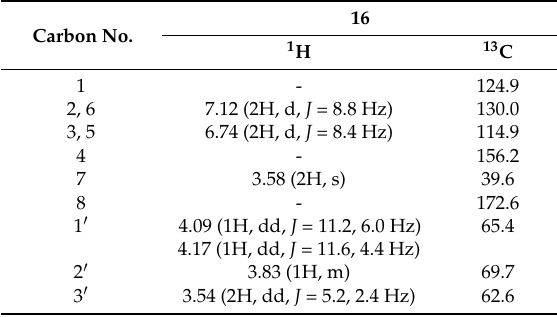
Table 2. 1 H- and 13 C-NMR spectroscopic data for compound 16